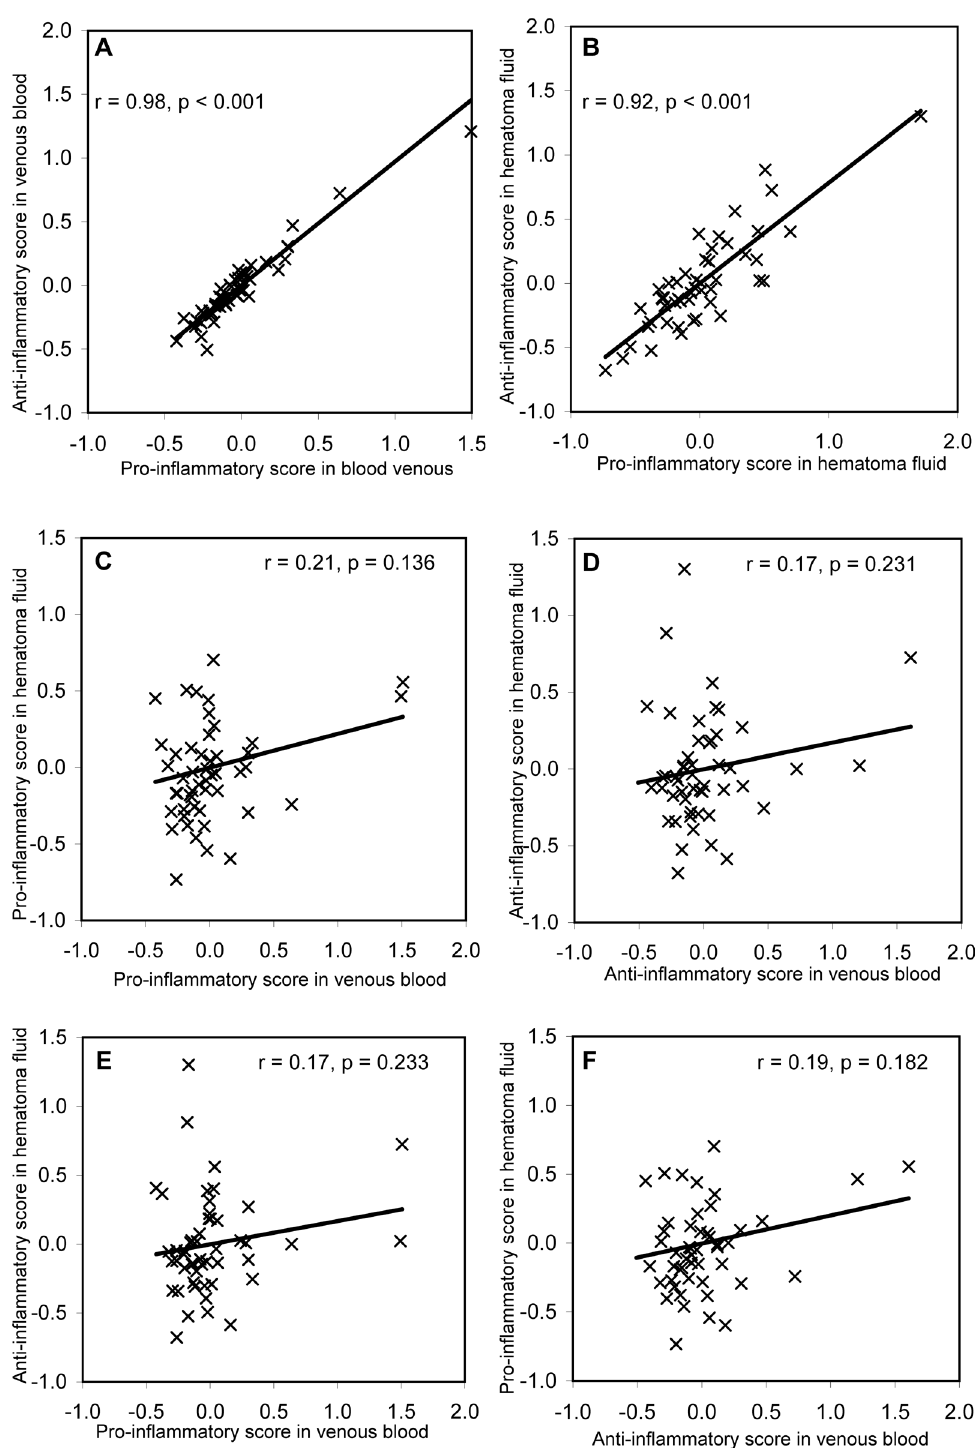
Figure 1. The correlation between the factor scores from the confirmatory factor analysis models in Table 3. These scores are the relative values of the underlying factors assumed to express pro- or anti-inflammatory activity in venous blood or hematoma fluid samples. They are statistically standardized to a mean of zero. The Pearson correlation coefficients and p-values are stated in the corresponding plots.